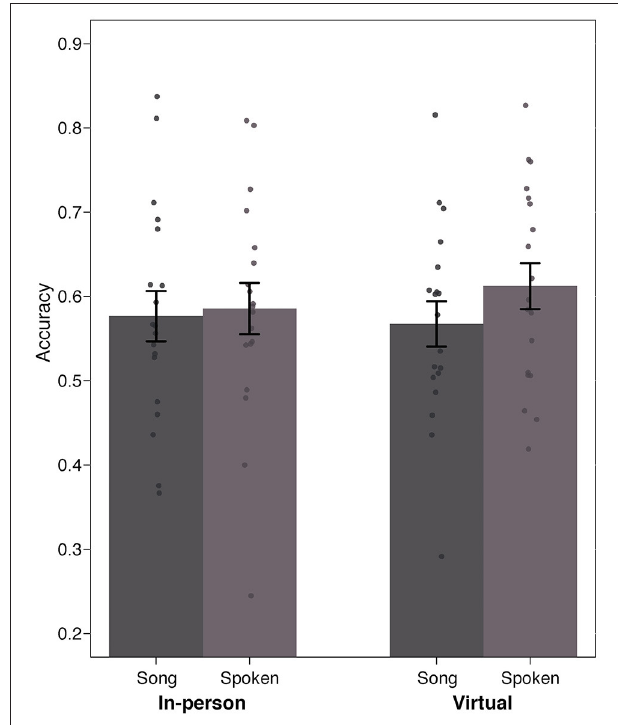
FIGURE 3 | Accuracy data based on proportion of looking to the correct object across the Song and Spoken condition in 29–32 month-olds.